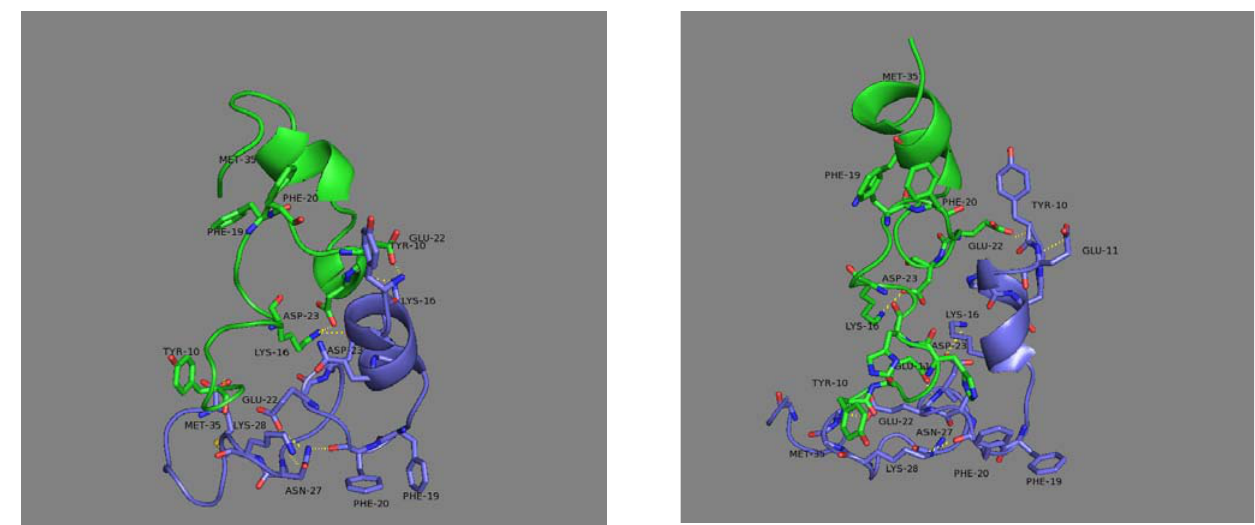
= E − E – E and bind C A B